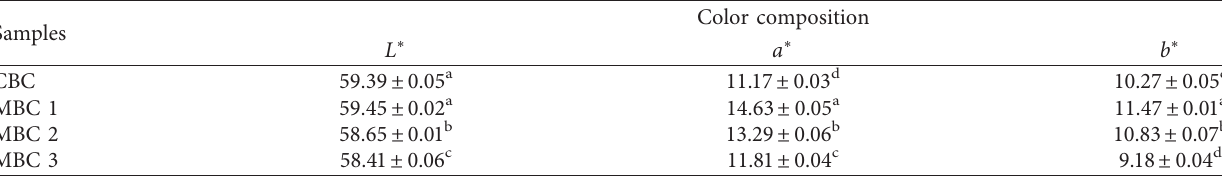
Table 5: Color composition of broiler chicken meat obtained from a genuine supplier and three different markets.